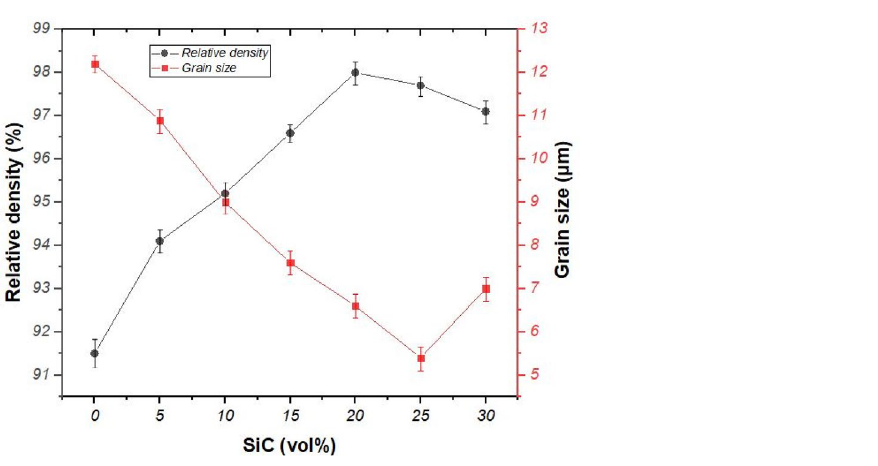
Figure 6. Plots depicting the variation of the relative density and grain size of in situ HfB 2 –SiC